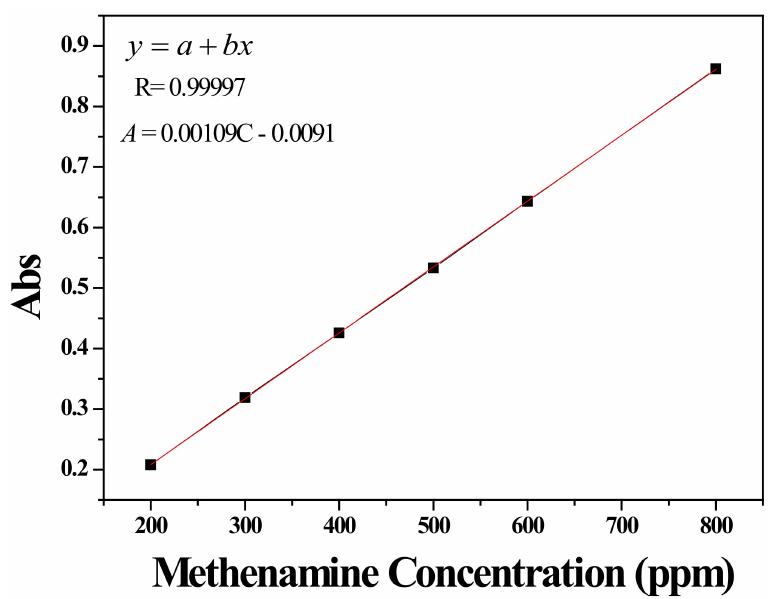
Figure 1. The calibration absorption curve of methenamine. The cumulative release concentration ( C ) at a particular time (t) can be calculated according to the